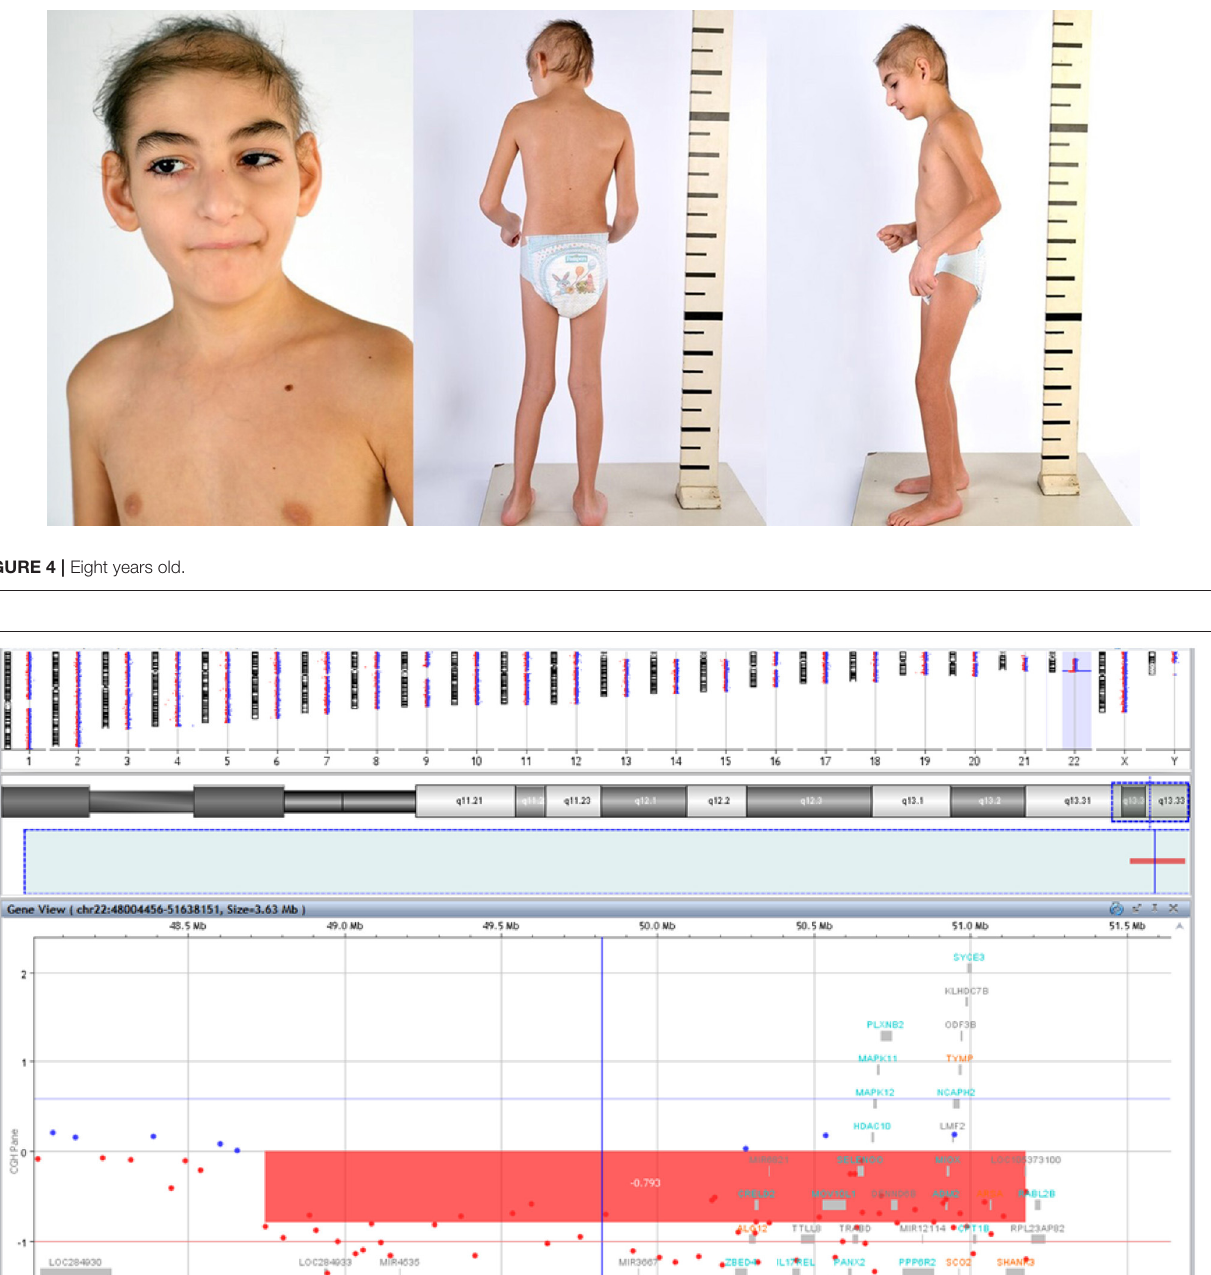
SureFISH probe Agilent (Santa Clara, CA, USA) 22q13.33 SHANK3 and chromosome 14/22 alpha satellite probe Acquarius Cytocell (Cambridge, UK) ( Figure 6B ), the results confirmed the CGH Microarray and karyotype analysis. The genetic study of both parents was